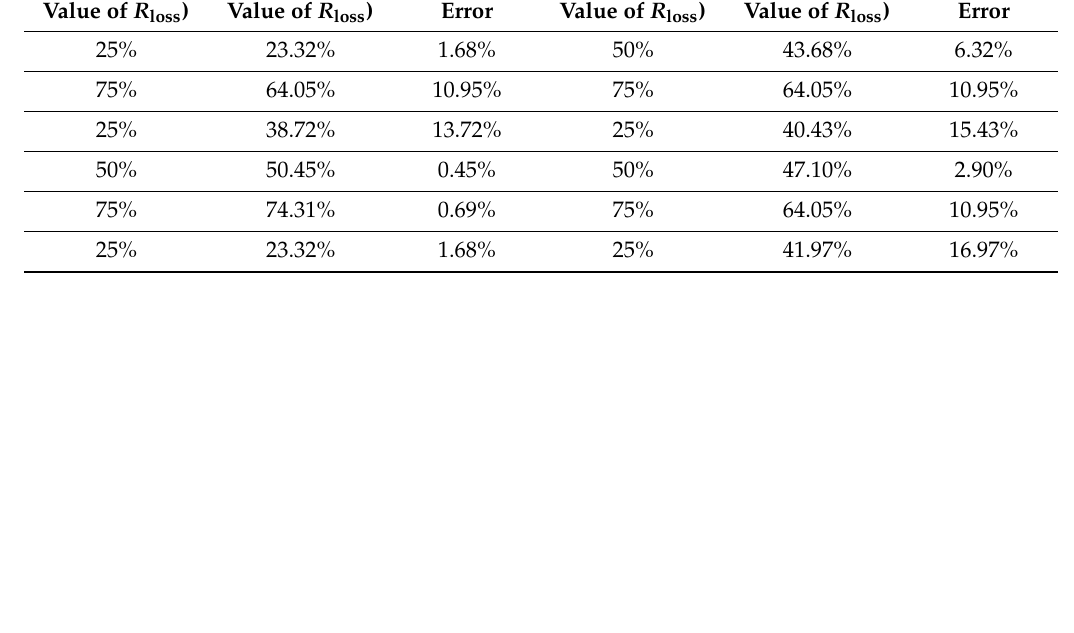
Figure 20. Fitted function between the univariate t m * and R loss .